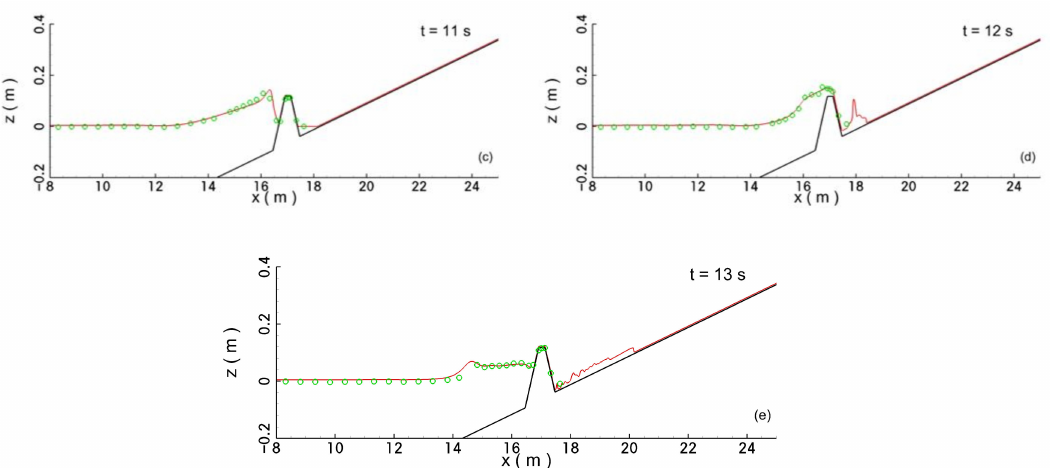
Figure 10. Comparisons of the spatial distributions of water surface elevations at different time